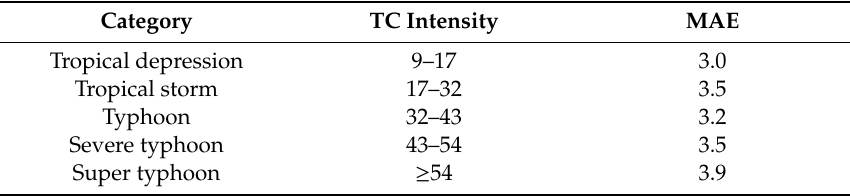
Table 3. The MAE (m / s) in the di ff erent categories of TC intensity (m /